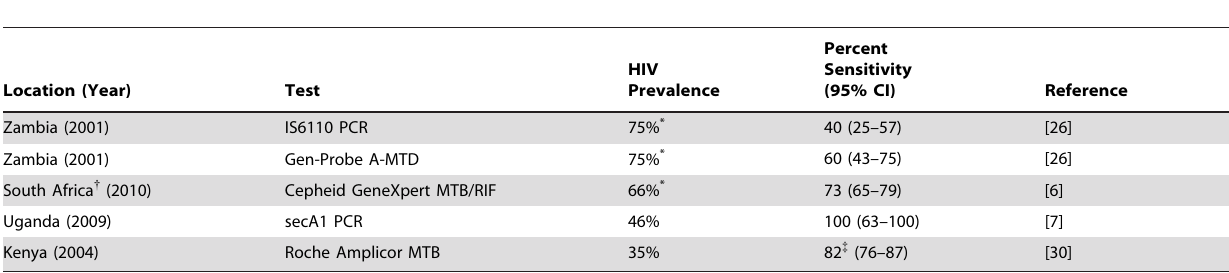
Table 4. Diagnostic performance of sputum nucleic acid amplification testing for TB diagnosis among smear-negative TB suspects in sub-Saharan